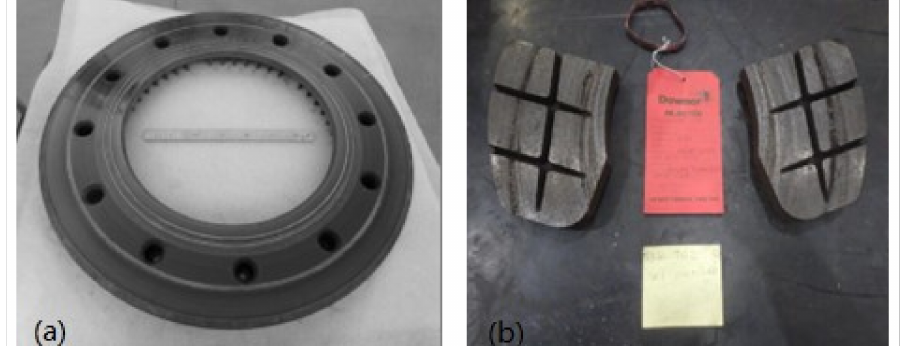
Figure 1. ( a ) General view of Brake Disc 1 from the affected trainset. ( b ) General view of Brake Pad 1 from the affected trainset.